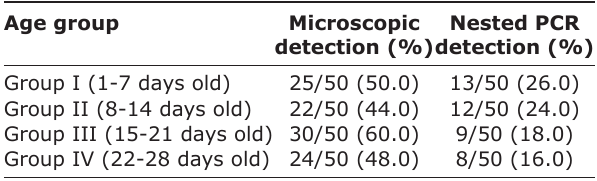
Table-2: Prevalence of Cryptosporidium spp. in each age group of newborn dairy calves. Age group